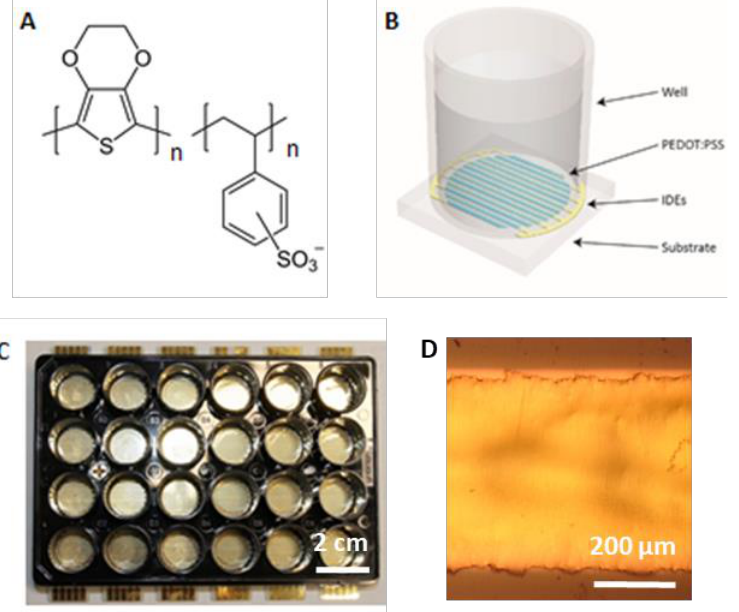
Figure 6. ( A ) chemical formula of PEDOT:PSS (source: https://en.wikipedia.org/wiki/PEDOT:PSS (accessed 12/12/2021)). ( B ) Schematic view of one well in a platform used for electrostimulation. Interdigitated electrodes (IDEs) covered with PEDOT:PSS are highlighted ( C ) The electrostimulation platform in the format of 24-well plate. ( D ) Image of a section of gold IDE covered with PEDOT:PSS showing good alignment of PEDOT:PSS with gold support. Image was taken with Nikon Eclipse E200 microscope equipped with D5000 camera (Nikon Europe BV, Amsterdam, Netherlands). The